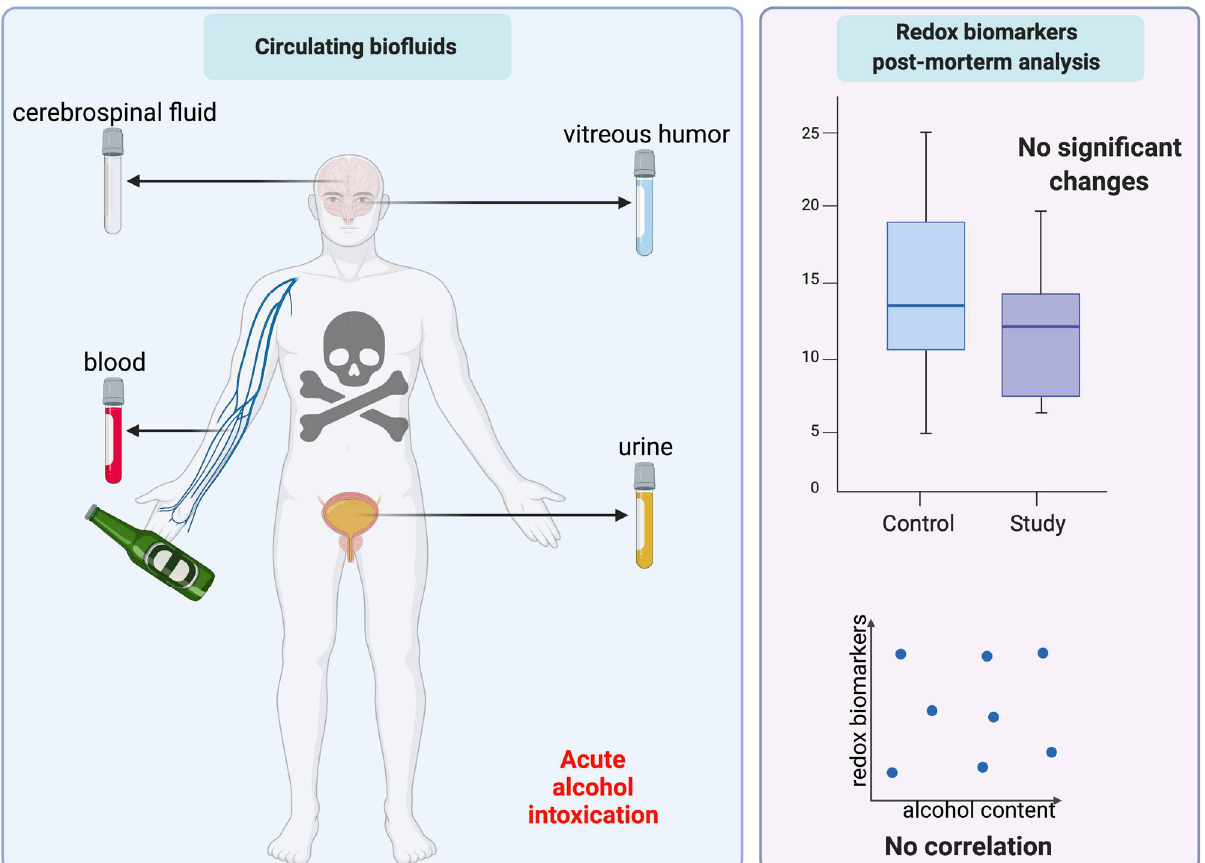
Figure 5. Graphical conclusions from the study.